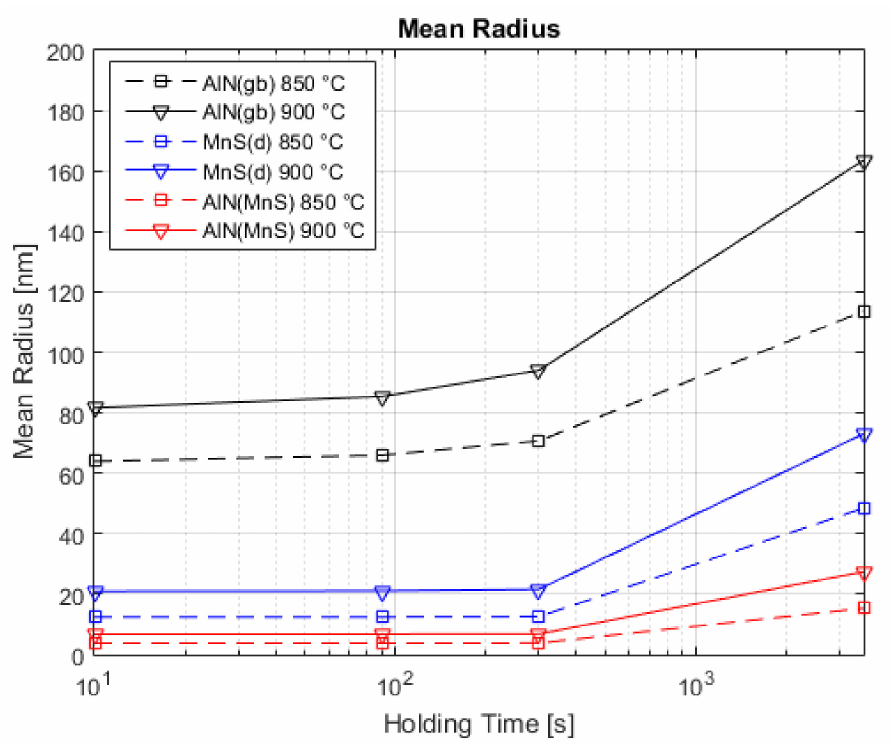
Figure 13. Results of mean radius simulations for AlN at grain boundaries, MnS at dislocations, and AlN at MnS for different temperatures and holding